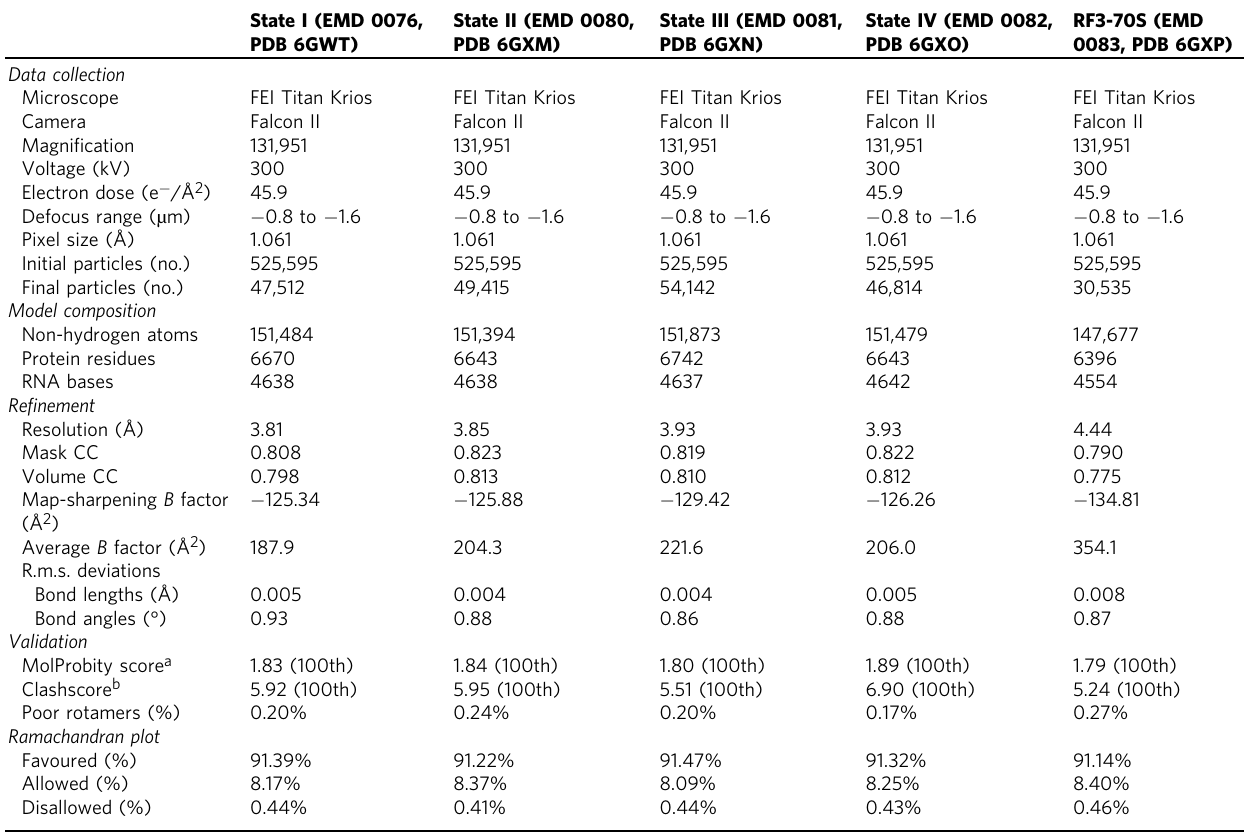
Table 1 Cryo-EM data collection, re fi nement and validation